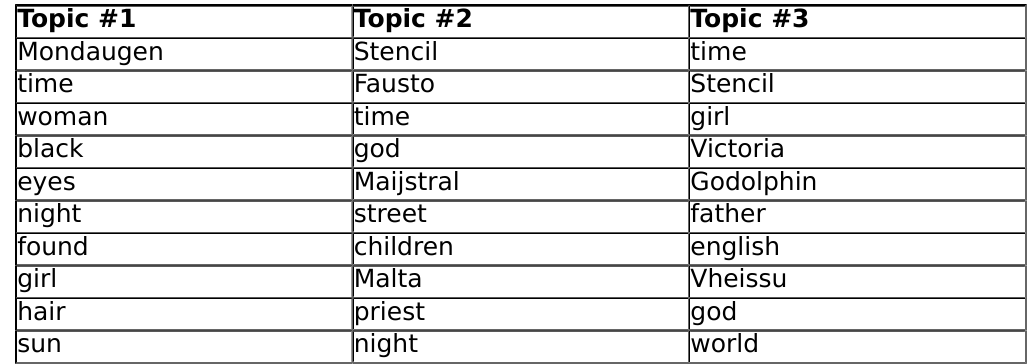
Table 5: The 10 most probable terms for each of the three topics found in the V. storyline chapters, as shown in Table 4. Notice the presence of the most frequent terms, as shown in the wordcloud of Fig. 1 above. Uppercase letters have been manually restored where appropriate for the